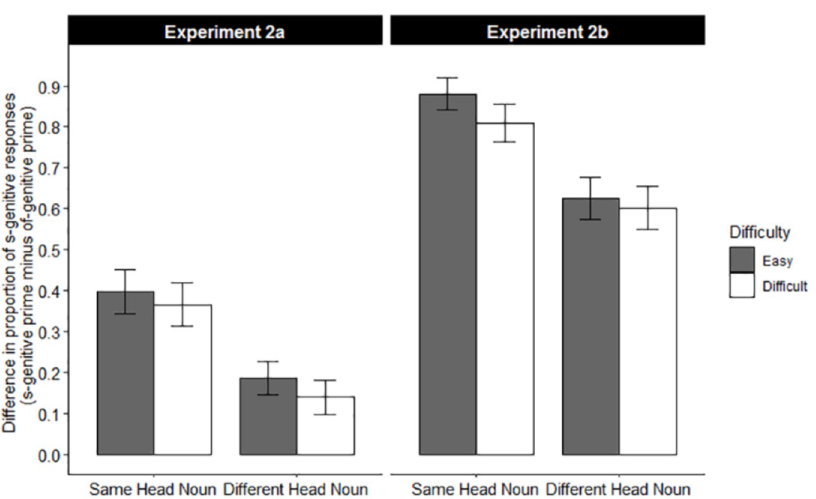
Fig 4. The priming effect (s-genitive production in s-genitive condition minus that in of-genitive condition) as a function of head noun condition and problem difficulty in Experiment 2a and 2b. Error bars reflect standard errors calculated for a by-participants analysis.